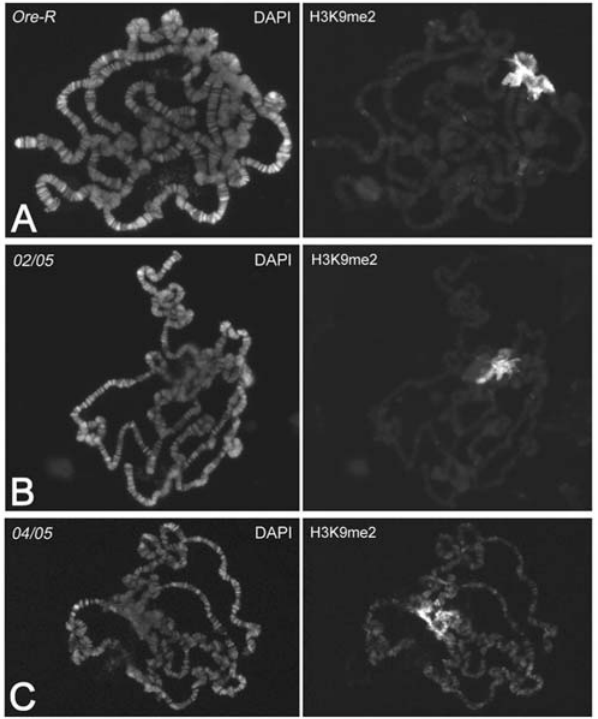
Figure 3. A mutated chromodomain of HP1a does not modify the immunopattern of Histone H3 di-methylated at lysine 9 (H3K9me2). (A) Immunopattern of H3K9me2 on polytene chromo- somes of wild type larvae ( Ore-R ). The immunosignals are mainly present on the chromocenter. (B) H3K9me2 immunopattern on polytene chromosomes of Su(var)2–5 02 /Su(var)2–5 05 ( 02/05 ) larvae. The immunopattern is very similar to that of wild type. (C) H3K9me2 immunopattern on polytene chromosomes of Su(var)2–5 04 /Su(var)2–5 05 ( 04/05 ) null mutant larvae. In this case, the H3K9me2 immunosignals have been redistributed, even on euchromatic